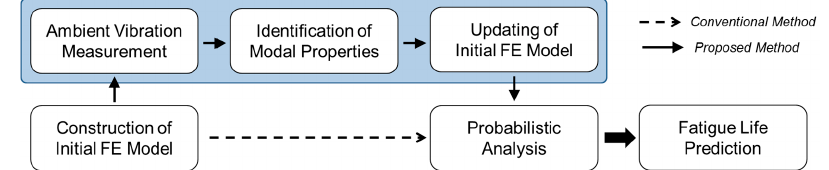
Figure 2. Flow chart of conventional and proposed fatigue life prediction procedures.